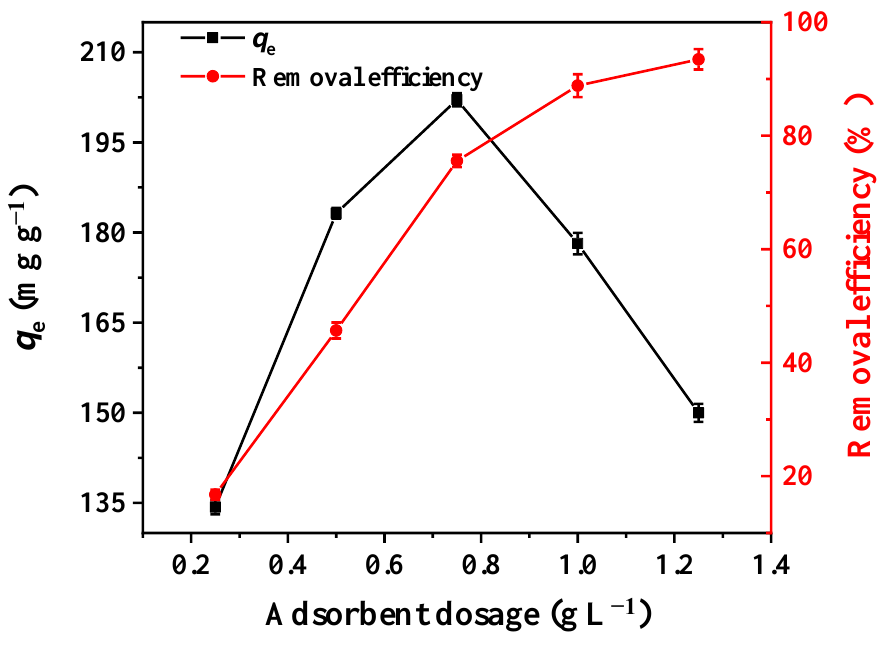
Figure 4. The effect of 2MgO/BC-450-0.5 dosage on phosphorus adsorption.